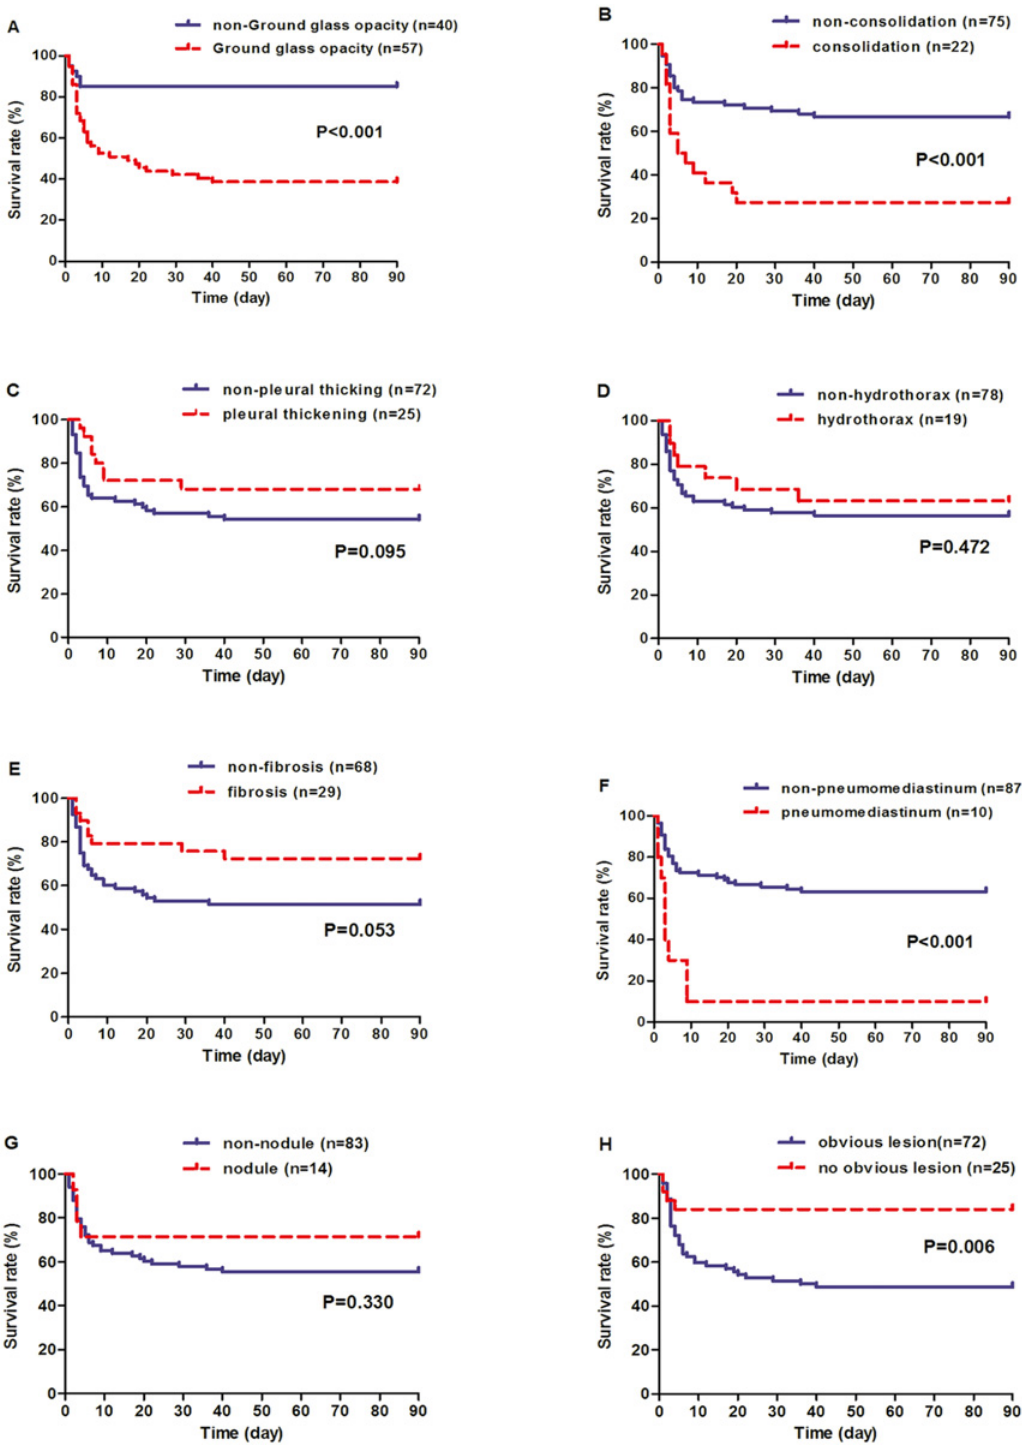
Fig 4. The receiver operating characteristic (ROC) curves constructed for outcome prediction by amount of paraquat (PQ) ingestion, plasma and urine concentrations of PQ, scores of Acute Physiology and Chronic Health Evaluation (APACHE) II and Sequential Organ Failure Assessment (SOFA), as well as volume ratio of Ground glass opacity and consolidation following PQ poisoning.